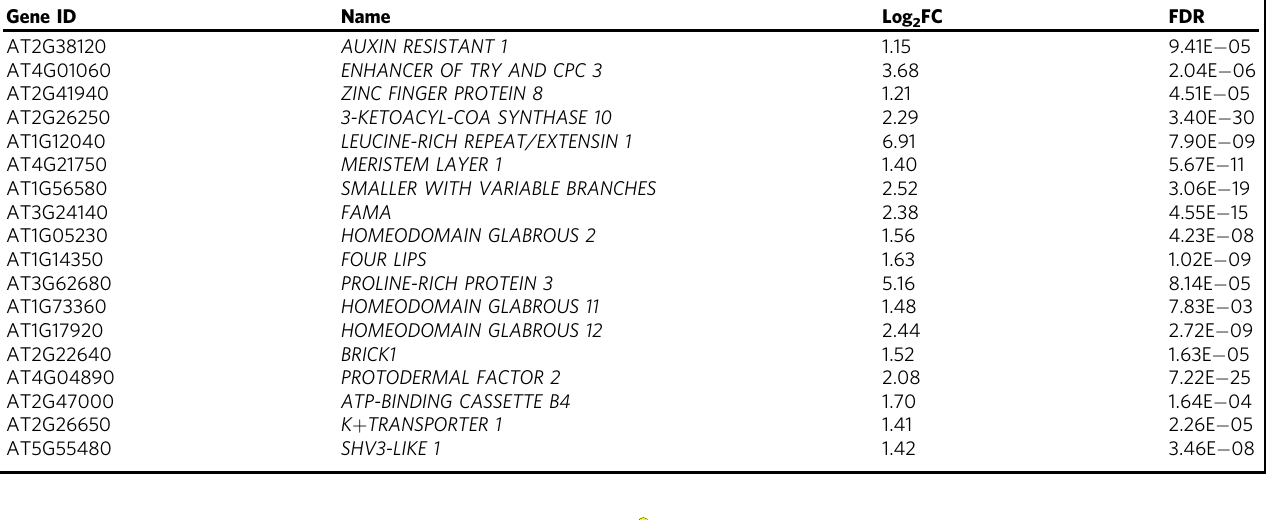
Table 2 Epidermal cell differentiation-related genes enriched in epidermal cells Gene ID